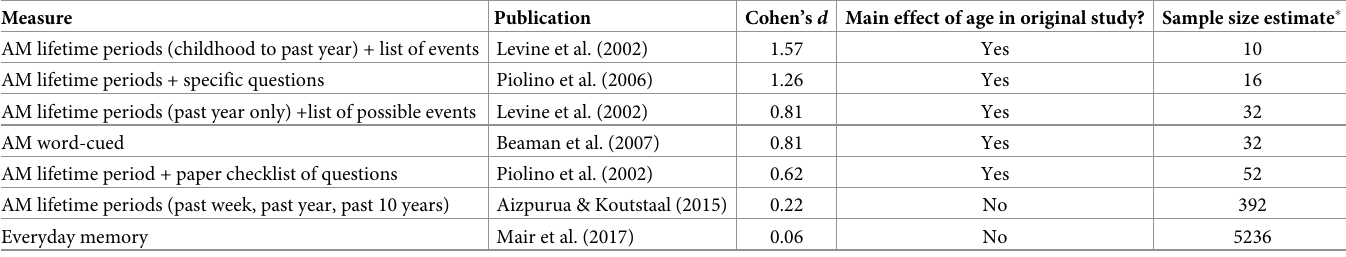
Table 1. Effect sizes for age effects in published AM research.